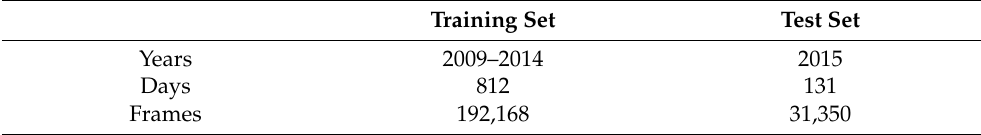
Table 6. The dataset used in the first